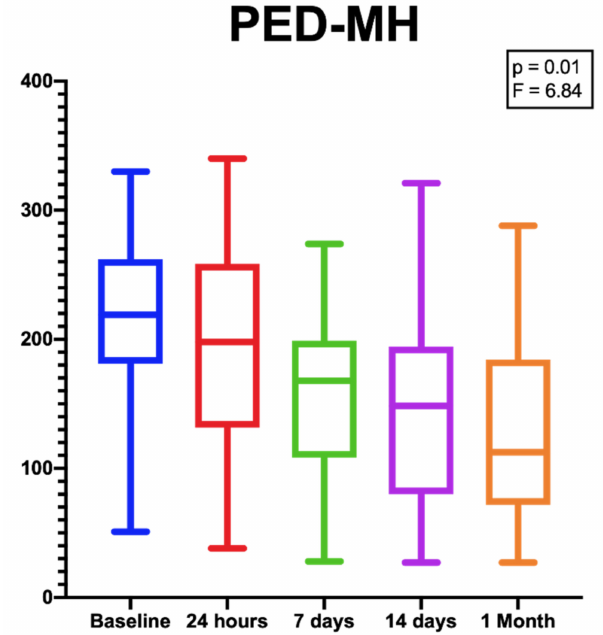
Figure 3. Box plots showing the significant reduction in PED-MHs from baseline to the end of the